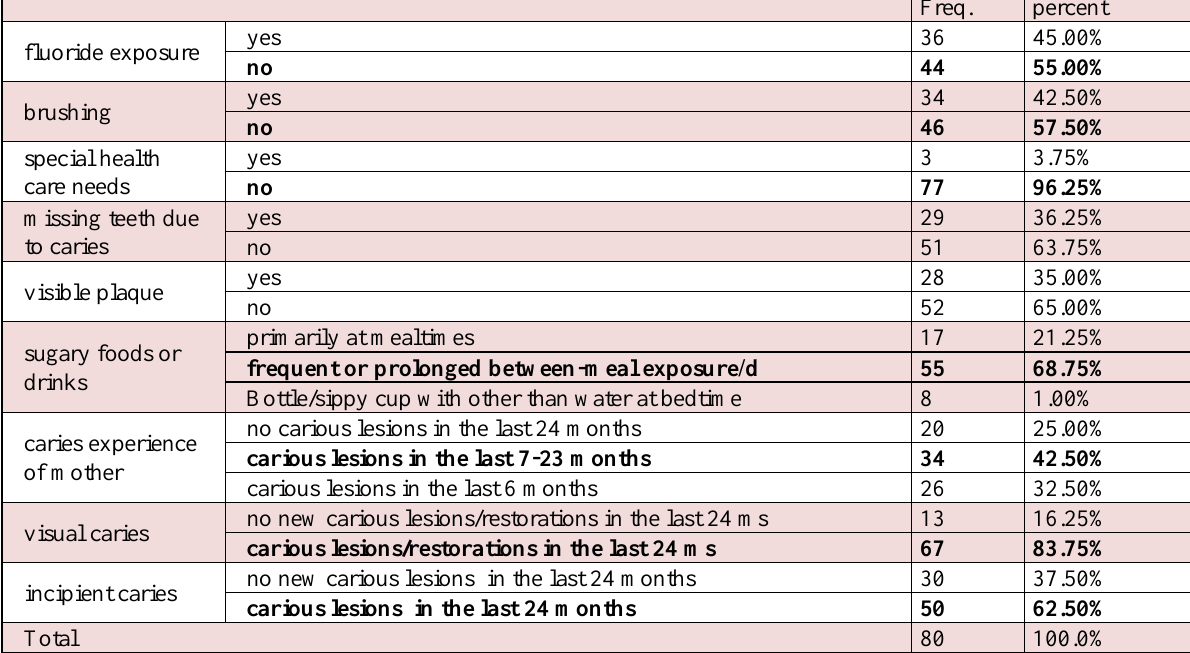
Table (1): Distribution of the participants according to risk criteria: